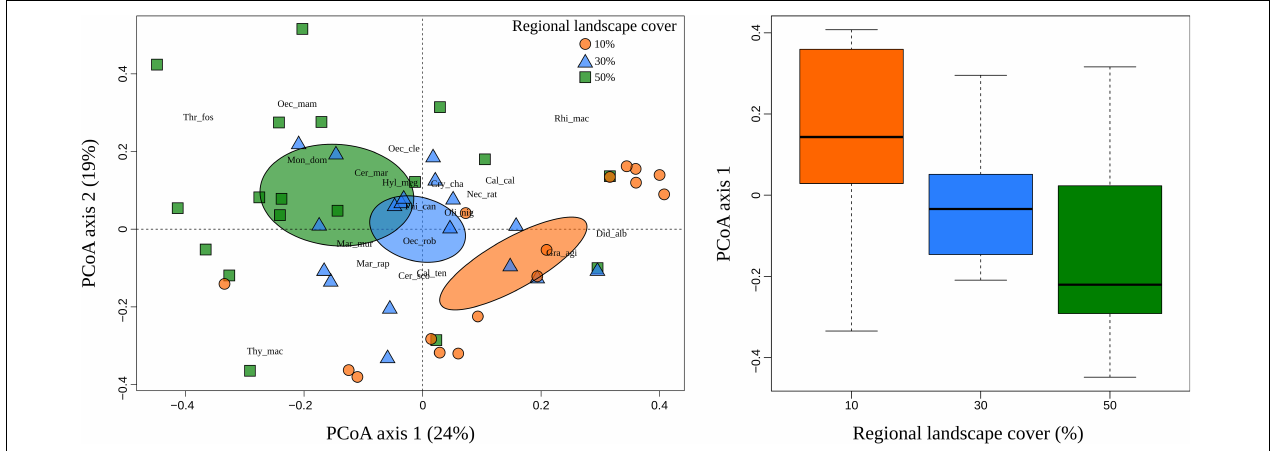
FIGURE 5 | First two ordination axes and boxplot showing the relationship of species composition and regional landscape cover in a woodland savanna region of South America. Principal Coordinates Analysis (PCoA) ordinations of sites within regional landscapes that have different amounts of the forest: 10% (orange circle), 30% (blue triangle), and 50% (green rectangle). Colored ellipses indicate the 95% confidence interval. For the sake of simplicity, we present abbreviated species names (see Supplementary Table 2 for full names). The box-plot at right shows the median position and the inter-quartile range (lower and upper quartile) of species pool according to each regional